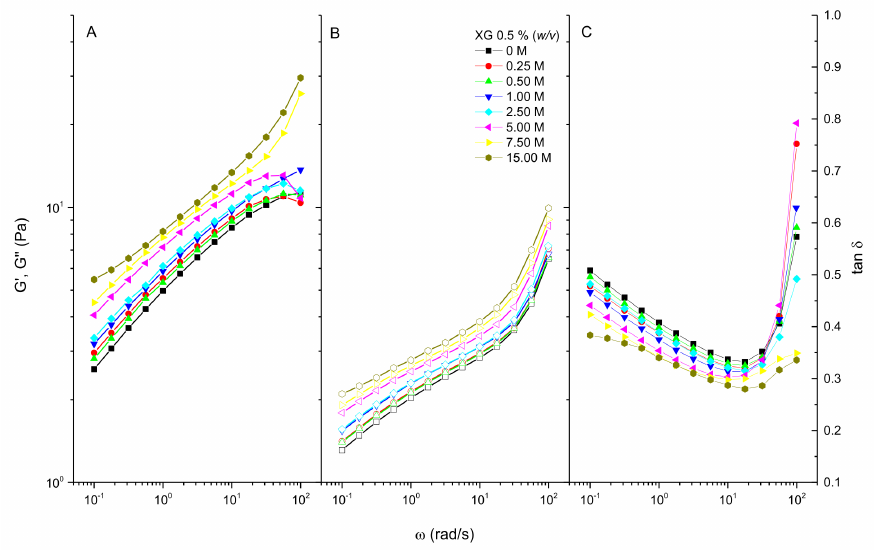
Figure 2. Evolution of the viscoelastic properties with the potassium formate concentration for fresh XG solutions at 0.5% ( w/v ) in HCOOK. ( A ) Storage modulus. ( B ) Loss modulus. ( C ) Loss